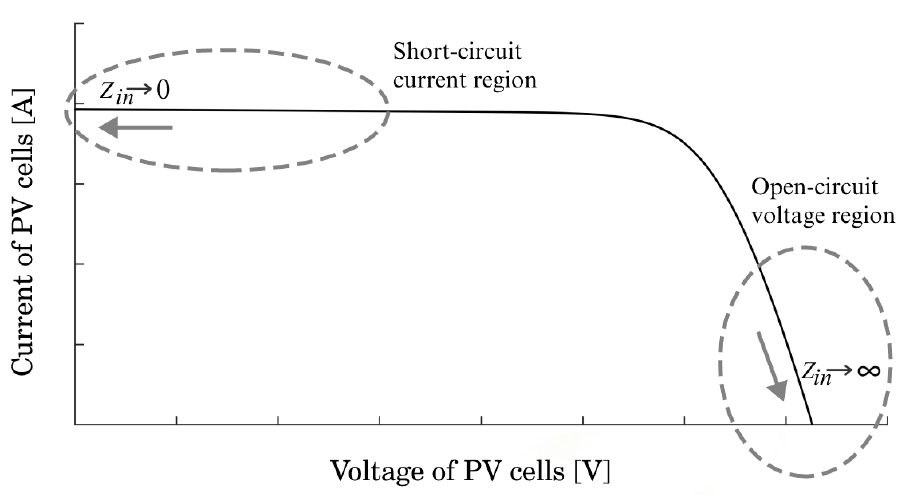
Figure 5. Voltage vs. current curve of the PV cells.